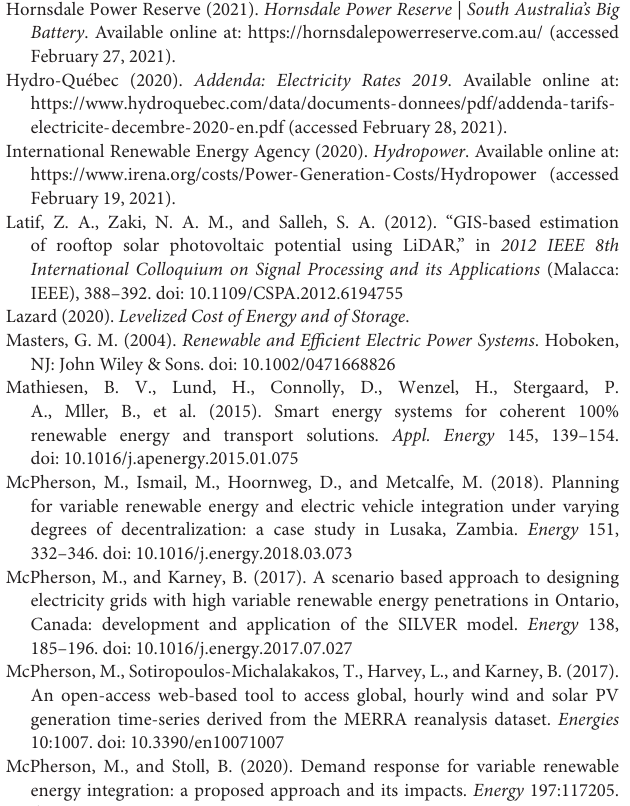
project. Energy Policy 68, 273–284. doi: